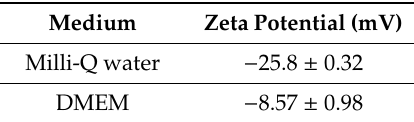
Table 2. Surface charge of TiO 2 NP suspensions in Milli-Q water and